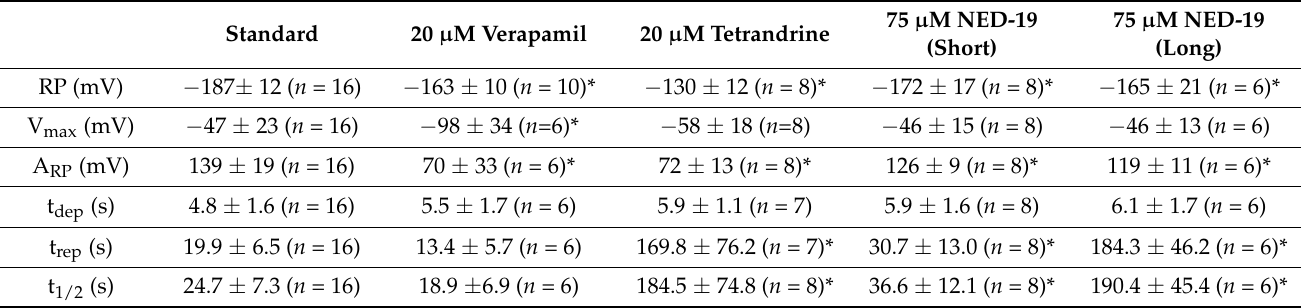
Table 2. Average values of resting potential ( RP ) and parameters describing the electrically evoked action potentials in Marchantia polymorpha thalli in the control plants and after the treatment with 20 µ M verapamil, 20 µ M tetrandrine, and 75 µ M NED-19. Asterisks indicate statistically significant difference ( p <